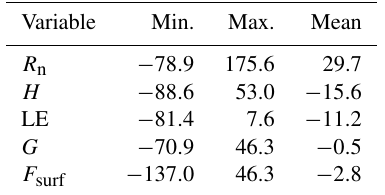
Table 3. Mean daily range of GEOtop-simulated SEB (Wm − 2 ) components for the study period (1 September 2015 to 31 Au- gust 2017) at South Pullu (4727ma.s.l.). Variable Min. Max. Mean R n − 78 . 9 175.6 29.7 H − 88 . 6 53.0 − 15 .